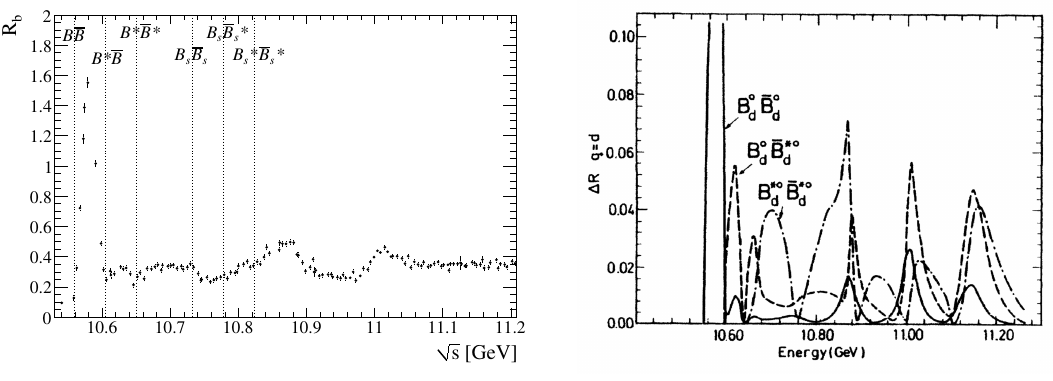
Figure 1 . The R b scan results from BaBar [1] (left), and the expected in Unitarized Quark Model contributions of the B ¯ B , B ¯ B ∗ , and B ∗ ¯ B ∗ channels [2]